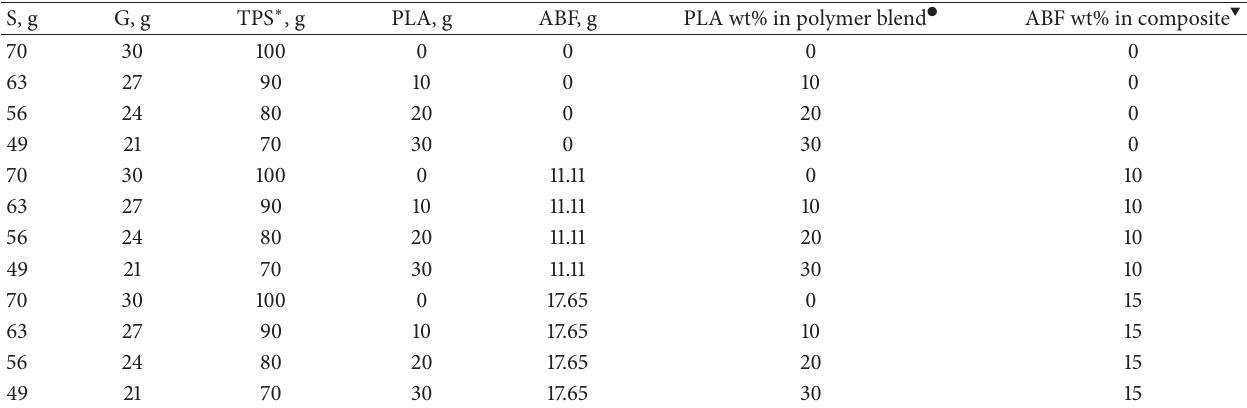
Table 1: Composite